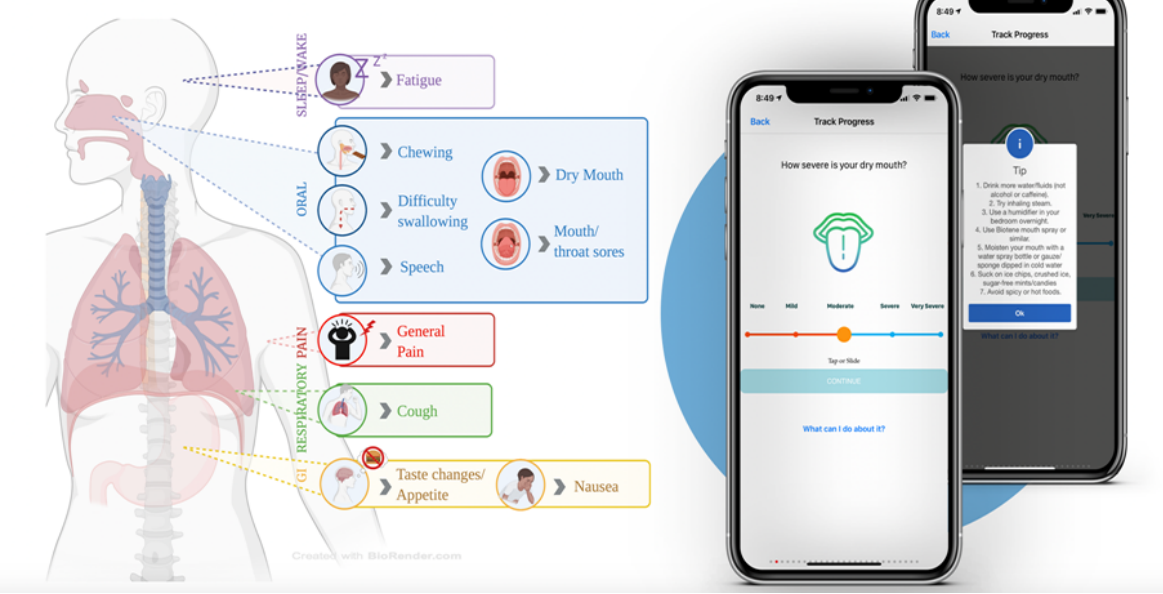
Figure 2. Examples of patient-reported outcome questions and illustrations of the relevant adverse effects. (Figure created on